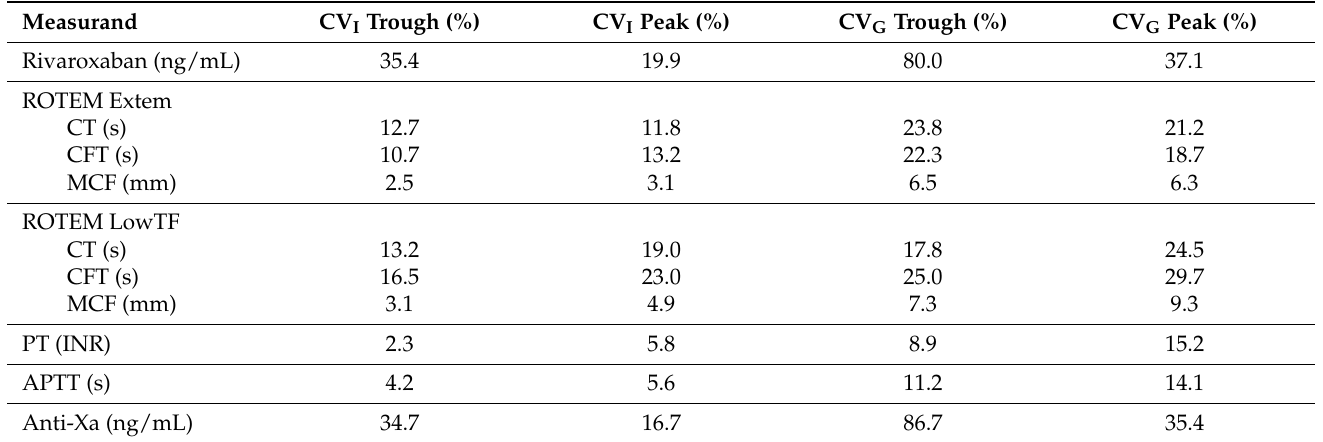
Table 3. Within- (CV I ) and between-subject (CV G ) biological estimates for rivaroxaban concentration, ROTEM Extem, ROTEM LowTF, PT, APTT, and